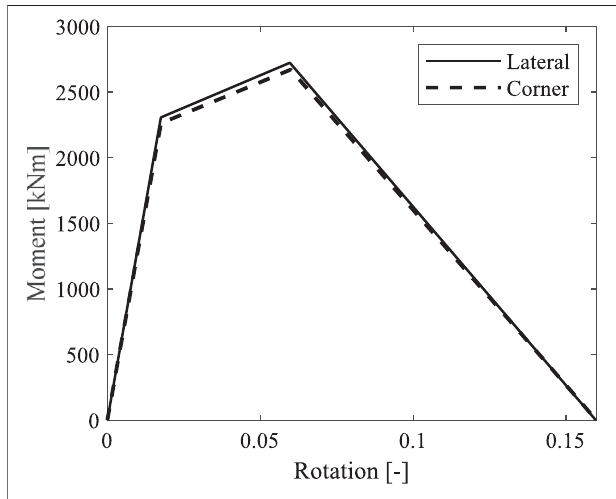
FIGURE 6 | Moment-rotation curves for corner and lateral